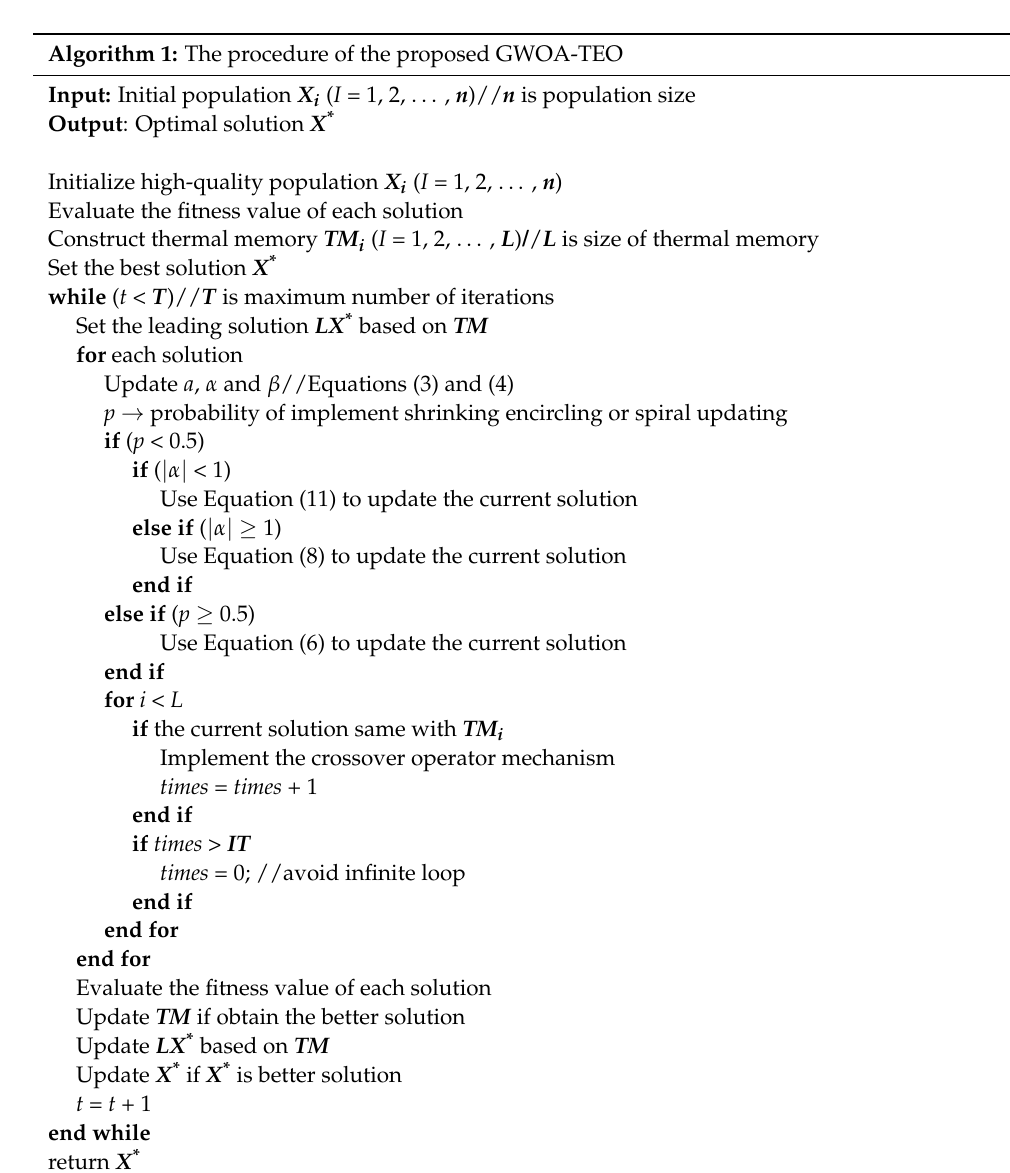
Algorithm 1: The procedure of the proposed